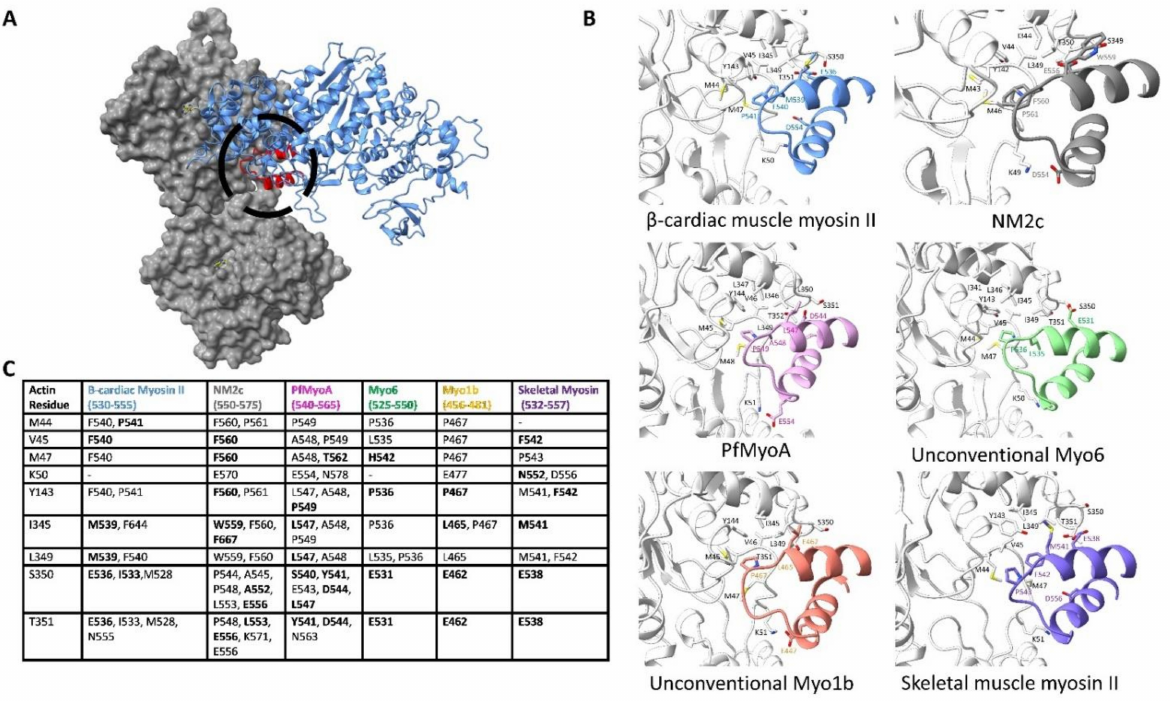
Figure 4. The actin D-loop hydrophobic patch buries the myosin HLH motif. ( A ). The basic positioning of the actin surface relative to the HLH motif in the motor domain. The motor domain is in blue while the HLH motif is colored in red and circled; actin is gray. ( B ). The residue-level binding interfaces between the actin hydrophobic patch surrounding the D loop and myosin HLH motif from the six different structures that are indicated in Supplementary Item Table S2. Because 6X5Z and 7JH7 are both cardiac β -myosin II isoforms, only one is shown for comparisons in the following figures. Actin backbone and residues are colored white, while myosin residues are colored by isoform. Noted residues involved in binding are shown and labeled. These types of depictions were made by extracting the central 2 actin subunits and 1 myosin from each cryo-EM structure and marking relevant residues involved in binding. It is apparent in these figures that the binding mode of the HLH motif is conserved in each myosin isoform. Conserved hydrophobic residues of the actin surface make contact with the HLH motif, while additional electrostatic interactions contribute to binding. ( C ). Residue-to-residue contacts determined for the cryo-EM structures indicated in Supplementary Item Table S2. All residues on myosin that come within 5 Å of the indicated actin residue are listed with residues coming within 4 Å appearing in bold. The actin sequence is based on the Chicken ACTA1 numbering (UniProt: P68139), which is within 1 residue of the other actin isoforms used in the six cryo-EM